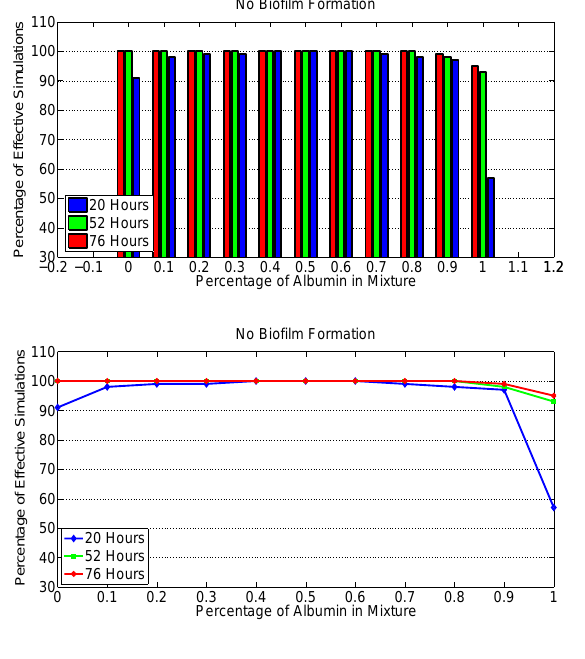
Fig. 4. Effect of no biofilm formation on bacterial growth on the surface of an implant. Discrete (above) and continuous (below) models results for T = 20 , T = 52 , T = 76